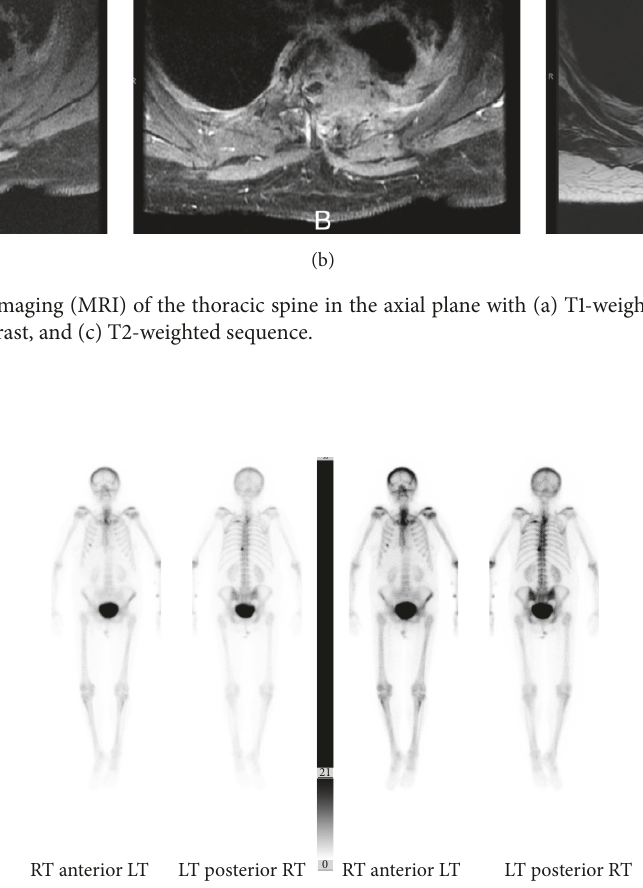
Figure 3: Bone scan showing tracer uptake in the upper T-spine and left 4th rib, corresponding to areas of direct tumour